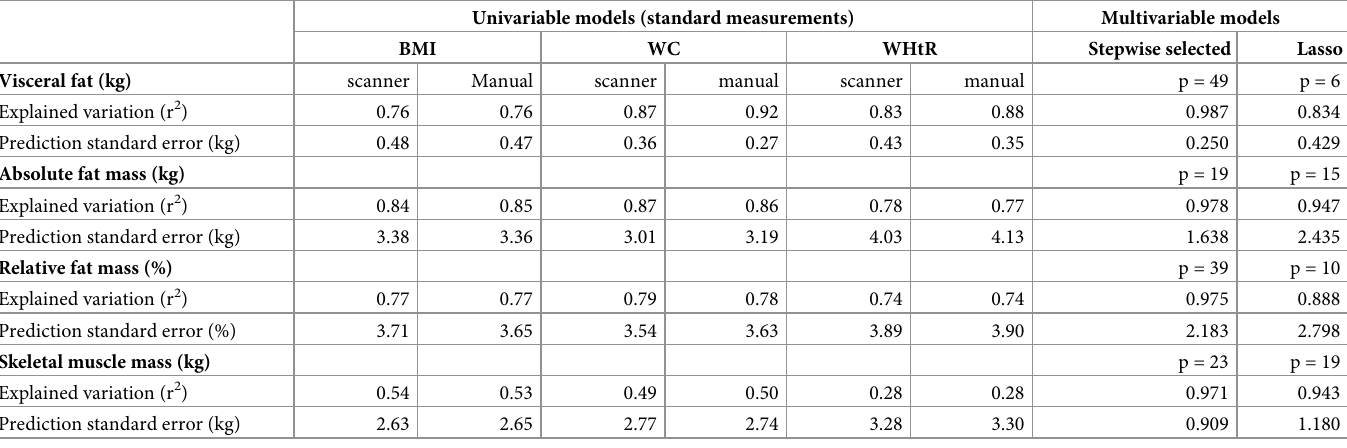
Table 1. Comparison of univariable and multivariable regression models for the prediction of body composition (fat or muscle mass as determined through BIA) from anthropometric measurements. In the univariable models, the four measures of body composition were related to three standard anthropometric measurements (BMI = body mass index, WC = waist circumference, WHtR = waist-to-height ratio, determined either with the 3D body scanner or through manual measurements) using linear regression or (for visceral fat) segmented regression. In the multivariable models, the four measures of body composition were related to 87 scanned measurements, from which the relevant predictors where selected either through stepwise forward model selection (to minimize the AIC) or through the lasso procedure. The fit of each model is given as explained variation (r 2 ), and its predictive value is given as the prediction standard error, i.e. the square root of the mean squared prediction error obtained by leave-one-out cross-validation.